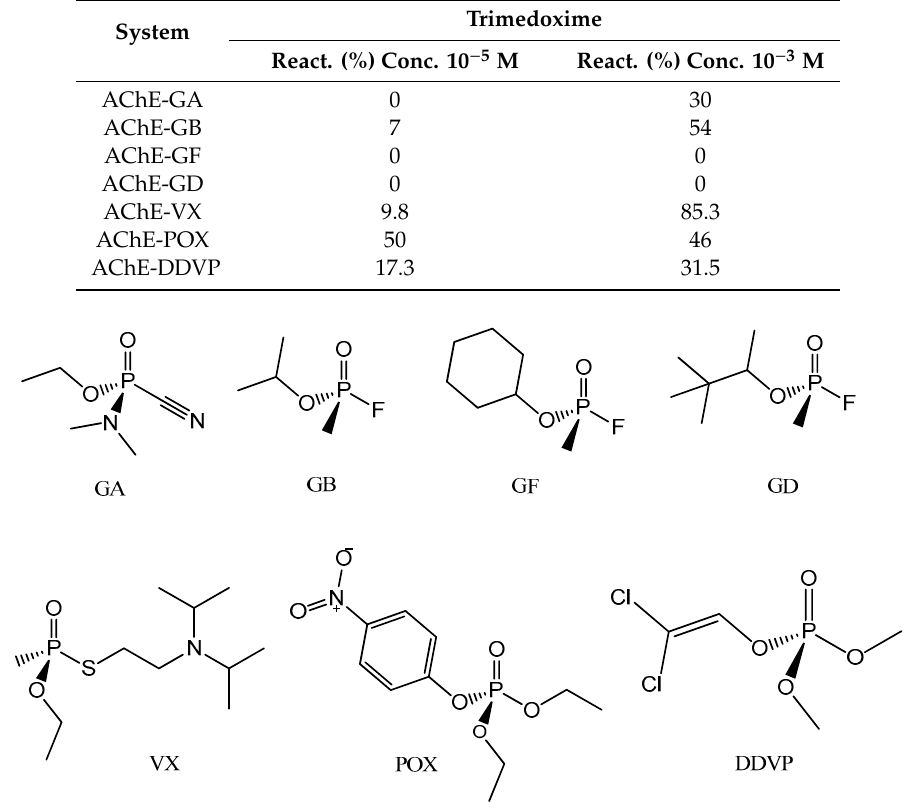
Figure 3. Chemical structures of the nerve agents used in the work.